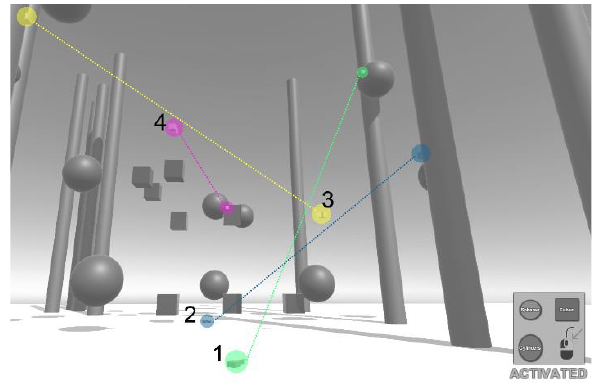
Figure 10 - Conceptual scheme illustrating the geolocation of values on objects in a virtual environment and the relation with users' location when creating the